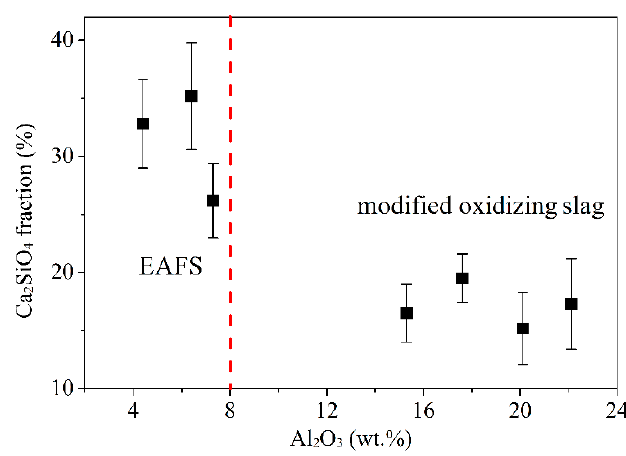
Figure 6. Effect of Al 2 O 3 content on C 2 S fraction of EAFS and modified oxidizing slag.